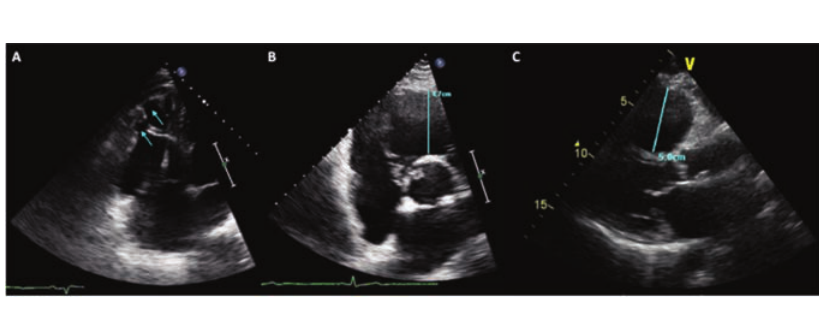
Figure 2. Echocardiography in patients with arrhythmogenic right ventricular cardiomy- opathy (ARVC) demonstrates right ventricular apical aneurysms in the four-chamber view (panel A), and right ventricular dilatation in the parasternal short axis (PSAX; panel B) and parasternal long axis (PLAX; panel C)